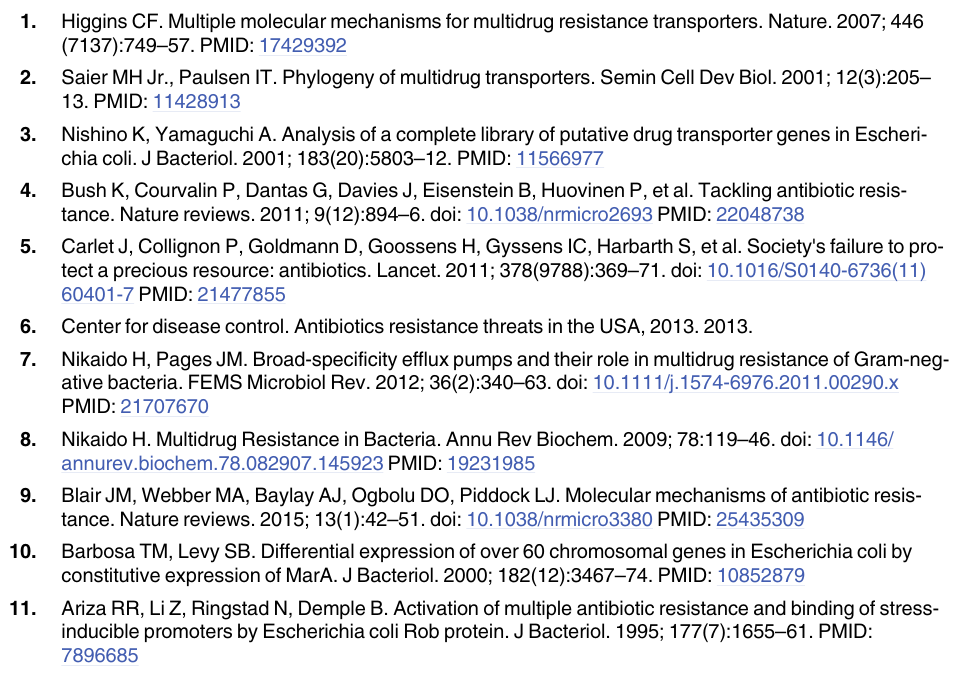
the presence of 0.1 μ M chloramphenicol and cultures that reached at least A600 = 1 were fur- ther diluted to LB-KPi containing twice the chloramphenicol concentration. The process was continued with a daily two-fold increase in the concentration for 24 days. Cells that did not hours. Inset: IC50 values were determined as described in Methods. S1 Table. Primers used for the determination of transcript